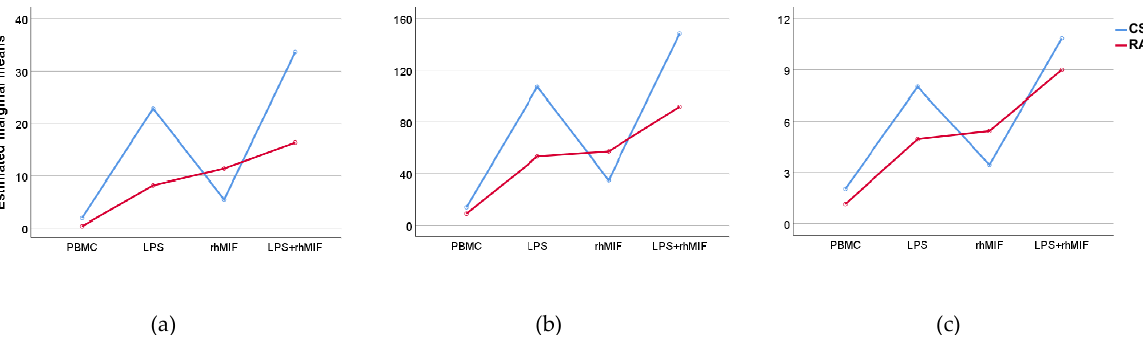
Figure 2. Interactions between the effect of stimuli and group of study on the secretion of the IL-25, IL-31, and IL-33 in the supernatants of PBMC from CS and RA patients after 24 h of stimulation with LPS and rhMIF: ( a ) IL-25. An effect of the type of stimulus, the study group, and their interaction on IL-25 secretion was found. Post hoc testing revealed